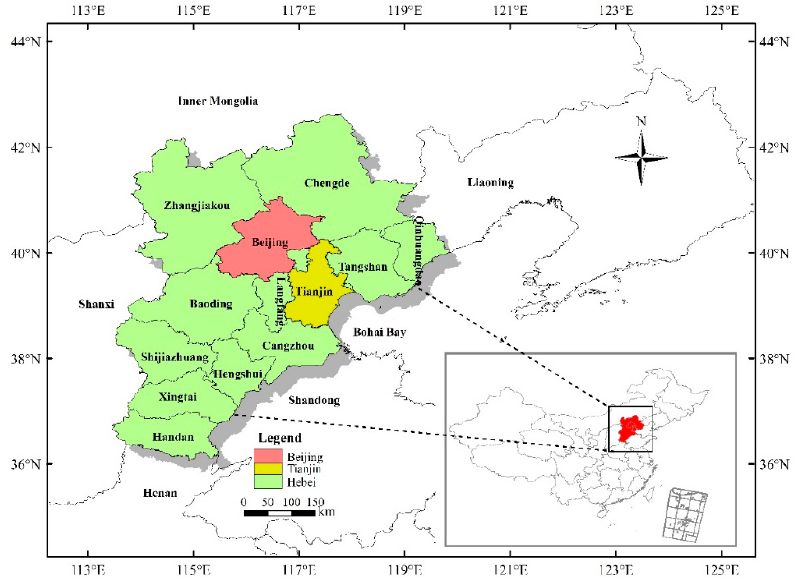
Figure 1. The location of the Jing-Jin-Ji region.